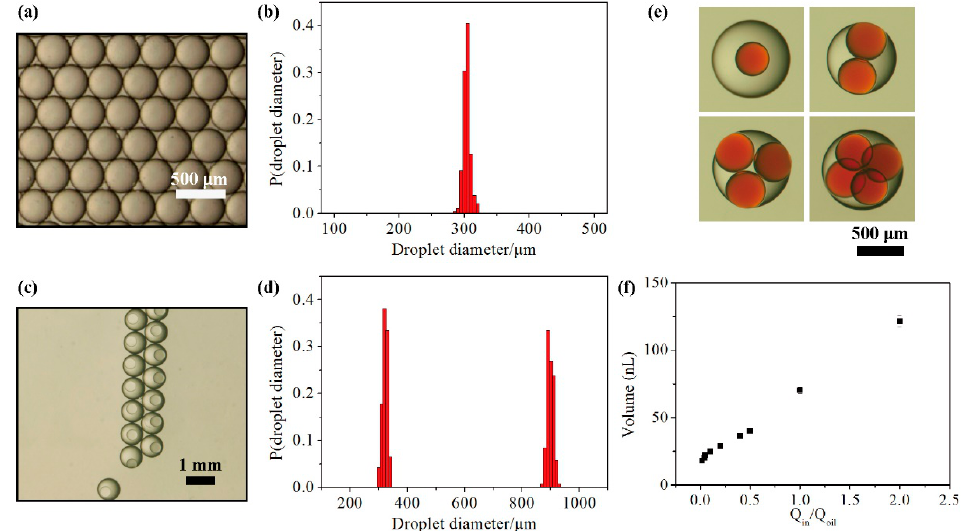
Figure 2. ( a , c ) Optical microscopic images showing single and double emulsions, respectively; ( b , d ) Performance of the plastic-glass hybrid microfluidic device by analyzing the diameter distribution of the collected single emulsions ( b ) and double emulsions ( d ); ( e ) Optical microscopic images showing multiple emulsions containing single, double, triple and quadruple core droplets, respectively; ( f ) Volume variation of the innermost solutions by applying different flow rate ratios of the inner aqueous phase and the middle oil phase.